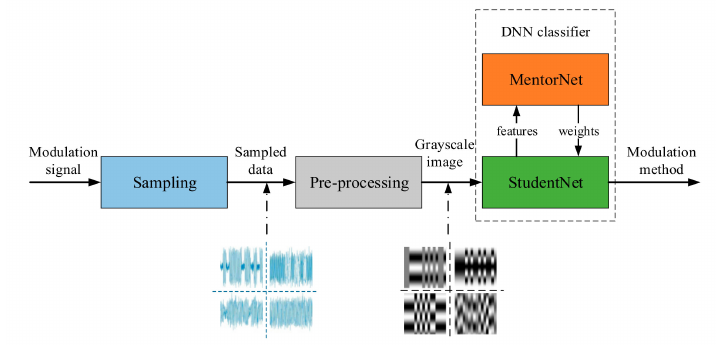
Figure 2. The diagram of the automatic digital modulation